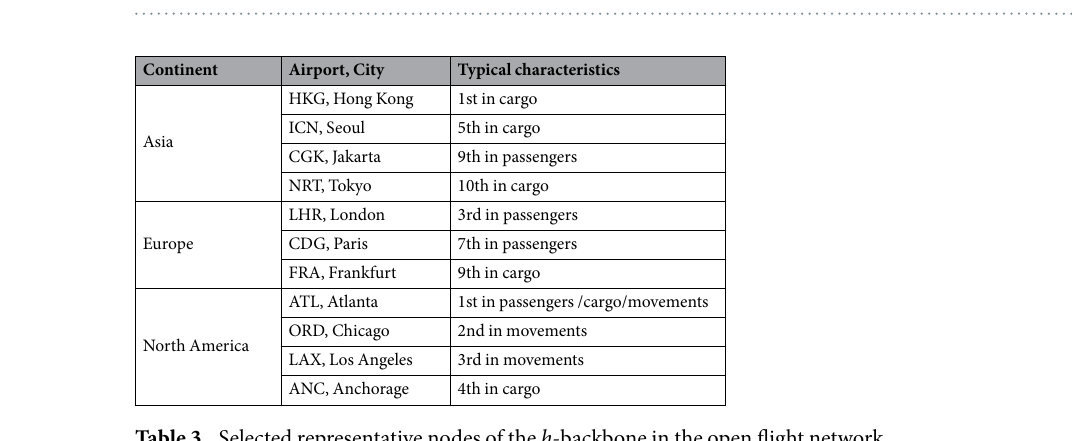
Figure 2. The h -backbone of the open flight network.